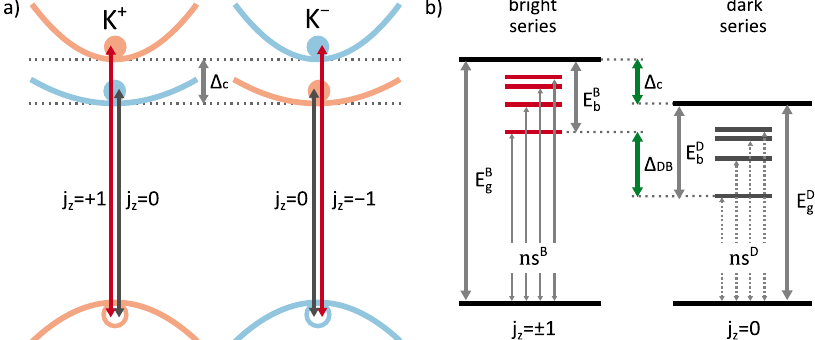
Fig. 1 Schematic illustrations of bright and dark transitions in WSe 2 monolayer. a Schematic representation of the interband transitions in a single- particle picture. The spin-up and spin-down states are shown as light-orange and light-blue parabolas, respectively. Optically active (bright) transitions at K + and K − valleys are represented by the red arrows, while optically inactive (dark) transitions are depicted in dark gray. The light-gray arrow represents the conduction band spin – orbit splitting ( Δ c ). b The energy diagram of excitonic transitions: Rydberg series of bright ( n s B ) and dark ( n s D ) resonances. The horizontal red and dark-gray lines represent bright and dark excitonic levels, respectively. The light-gray arrows represent the bandgaps for bright and dark excitons ( E B = D g ) and the binding energies of the ground states of bright and dark excitons ( E B = D ). The energy splitting between ground states of bright and b dark excitons ( Δ ) and the conduction band spin – orbit splitting ( Δ ) are represented by the green DB c